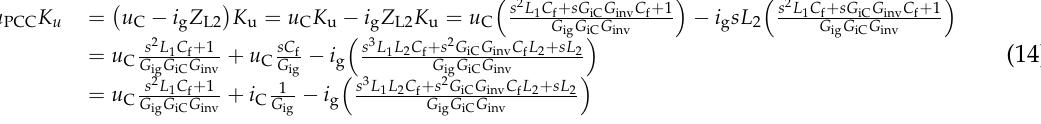
Figure 13. Comparison of the output impedance with the proposed method and multiple PR (Proportional Resonance) controller. The stability of the proposed control strategy can be determined by the ratio of the grid impedance and output impedance, that is, Z g / Z ’ ou should be satisfied with the Nyquist criterion [18]. Here, the grid impedance is 0.2 Ω / 0.08 mH, and Z ’ ou is shown in (11). It can be found that in Figure 14, there is no pole at the right side of the s plane, and its Nyquist curve does not circle the point − 1 + j 0. According to the Nyquist criterion, this system is stable.